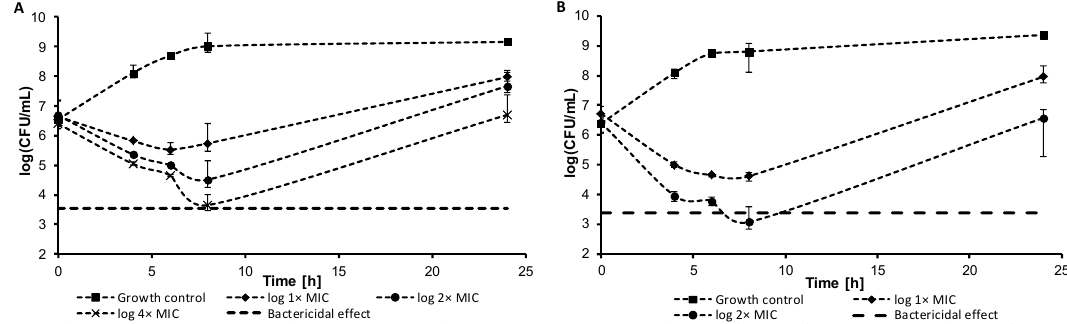
Figure 2. Time-kill curve of compound 6 ( A ) and compound 13 ( B ) against S. aureus ATCC 29213.